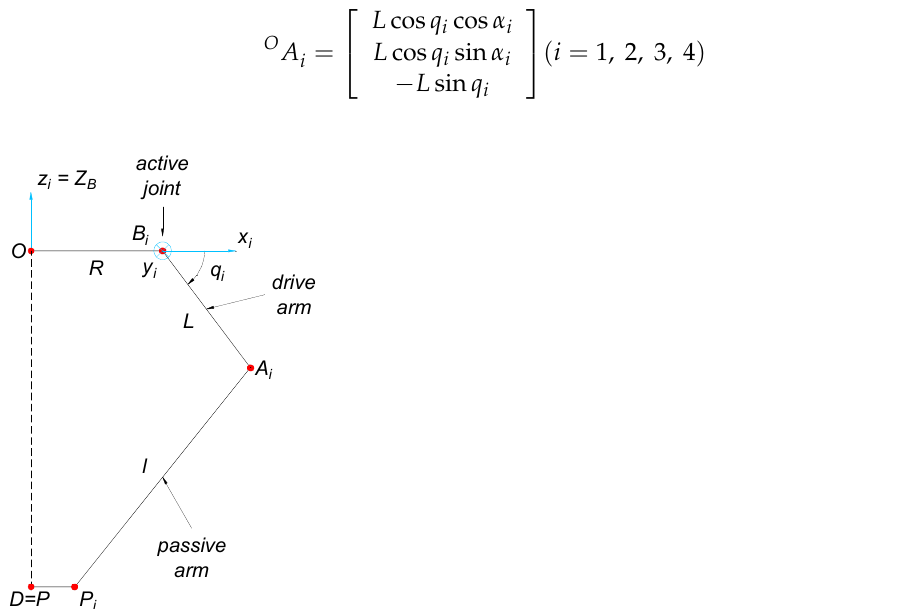
Figure 5. Overview of one arm with indicated characteristic dimensions.